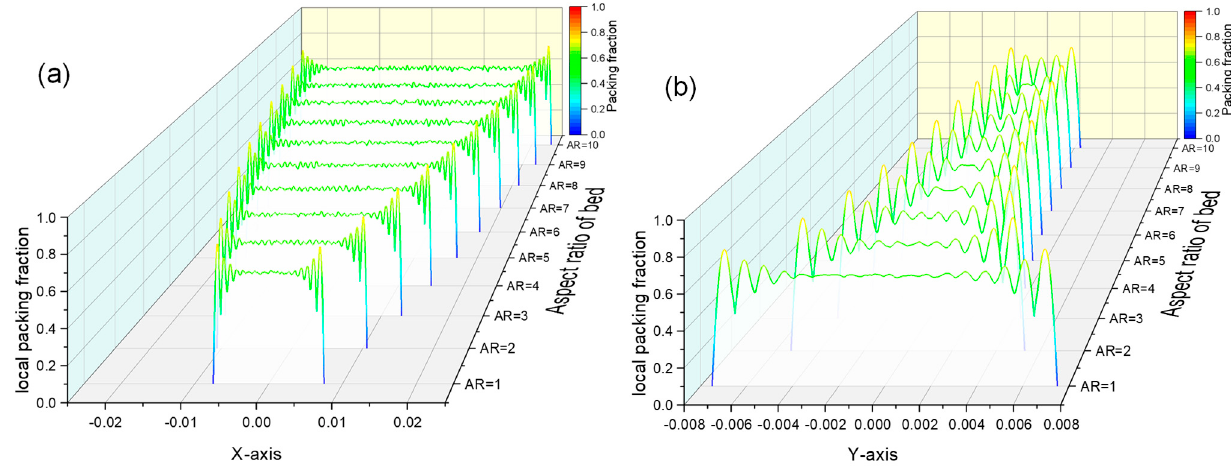
Figure 10. Axial packing fraction variations along ( a ) x -axis (longer edge) and ( b ) y -axis (shorter edge) in pebble beds with various aspect ratios of 1–10 and a fixed cross-sectional area of 225 d 2 (Color online).